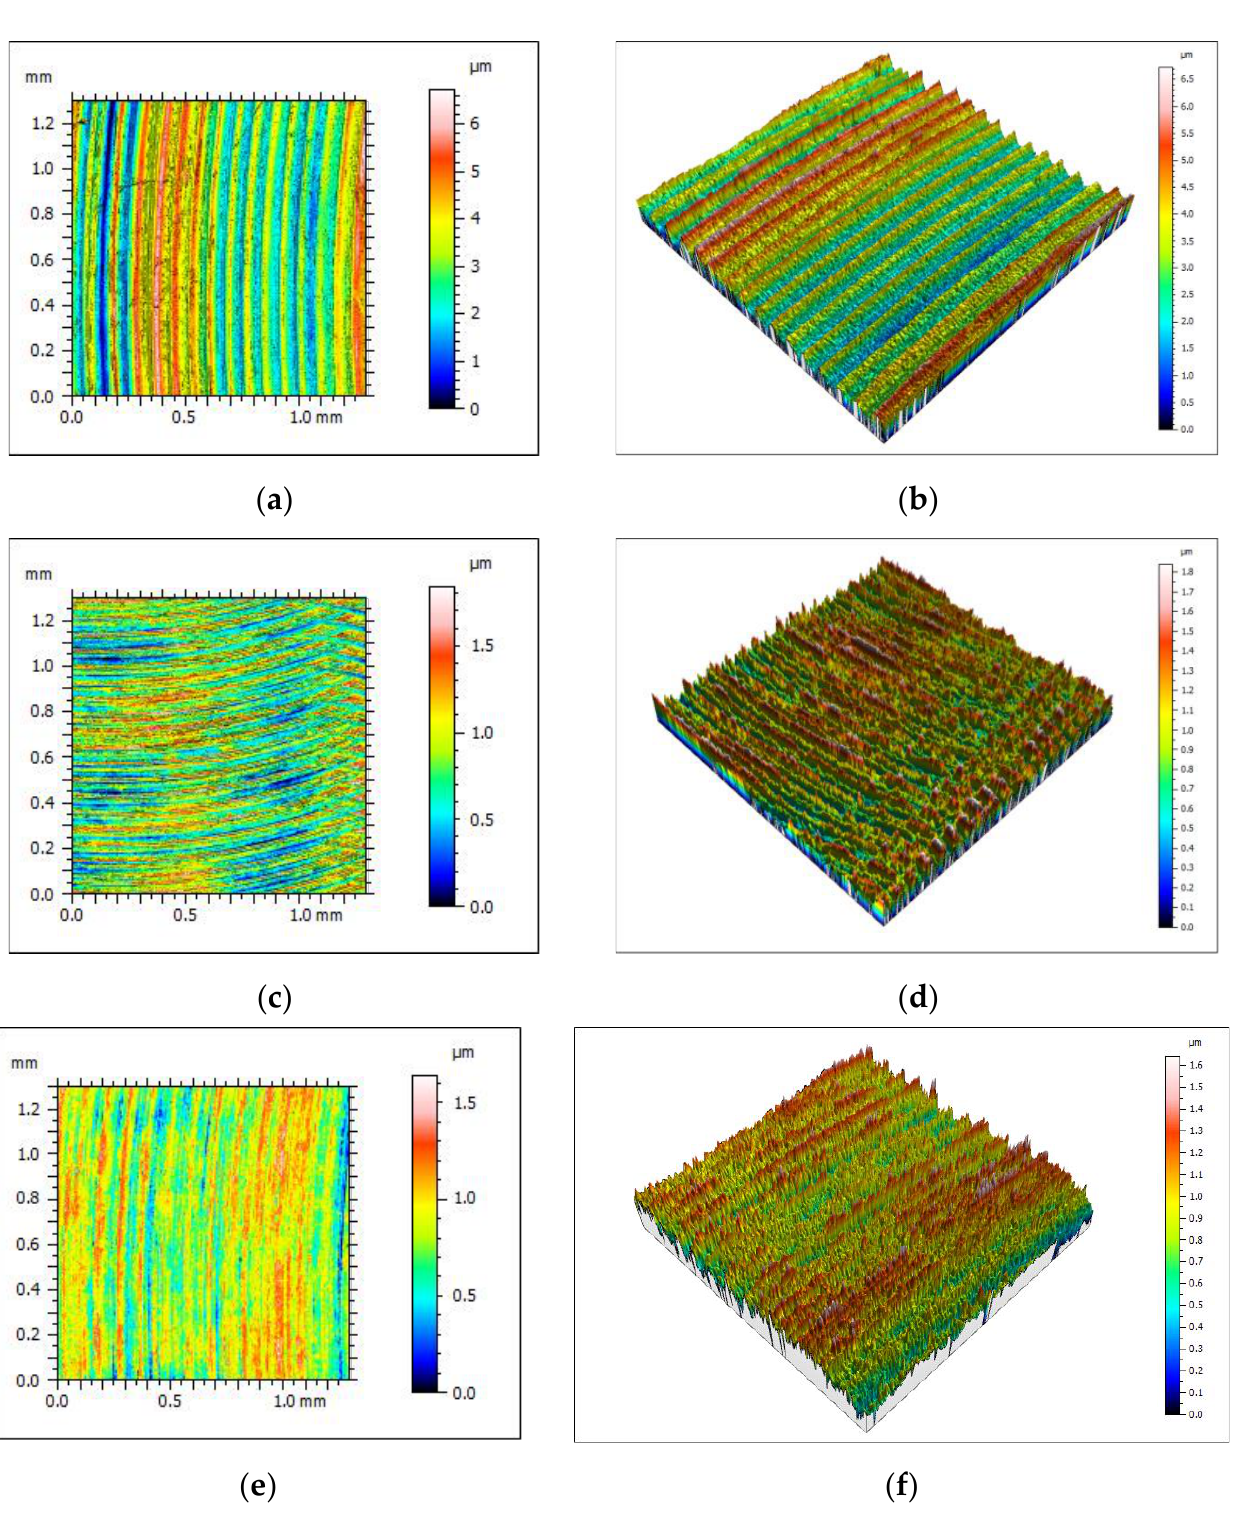
Figure 7. Contour map and isometric view of samples. ( a , b ) Coded D, ( c , d ) coded E, ( e , f ) coded F.